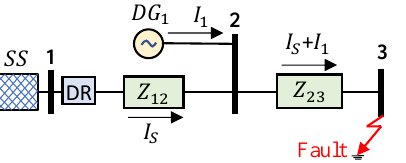
Figure 8. Radial distribution feeder with one DG—Method